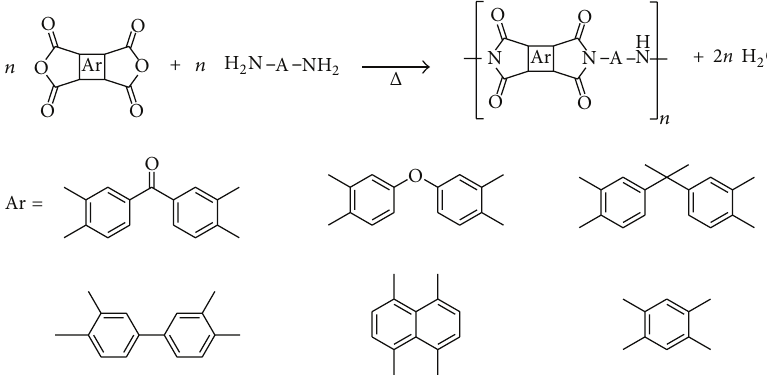
A = aliphatic, heteroaliphatic, aromatic, and heteroaromatic Scheme 1: Synthesis of polyimides from aromatic dianhydrides.